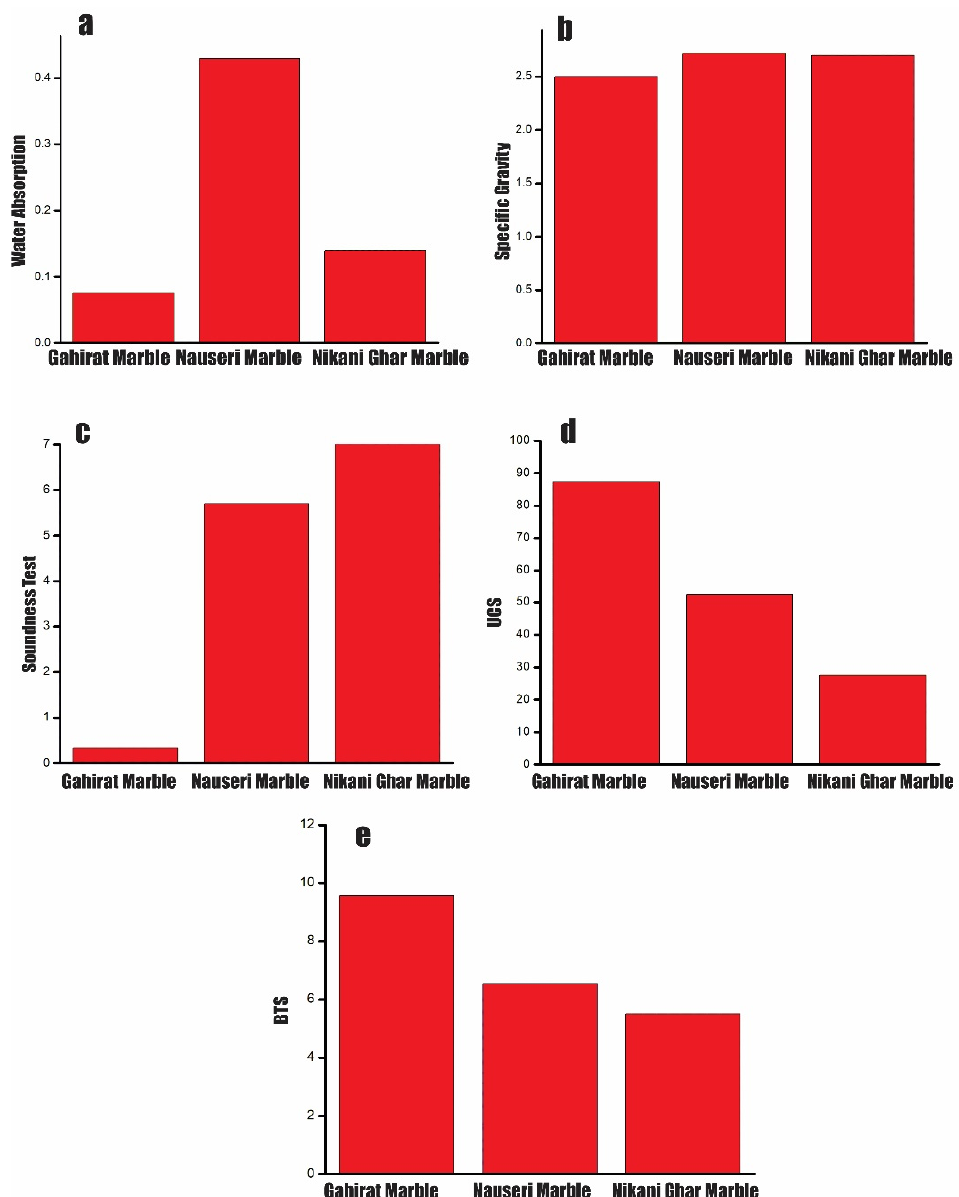
Figure 7. Comparison between the results of geotechnical tests of current study with Nauseri Marble [1] and Nikani Ghar Marble [26].( a ) comparison of different values of water absorption, ( b ) comparison of different values of specific gravity, ( c ) comparison of different value of soundness test, ( d ) comparison of different values of UCS, ( e ) comparison of different values of BTS. Table 3. Laboratory tests results from the study